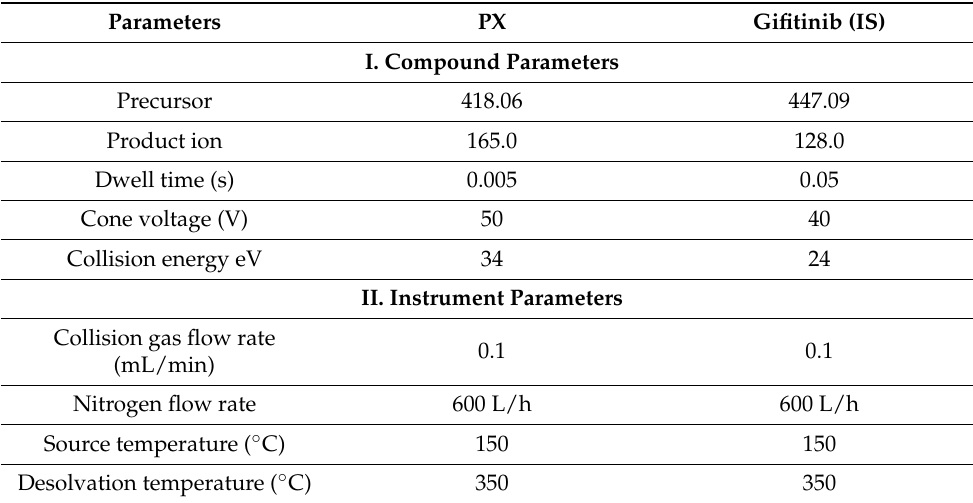
Table 1. Mass optimization parameters for PX and gifitinib (IS). Parameters PX Gifitinib (IS) I. Compound